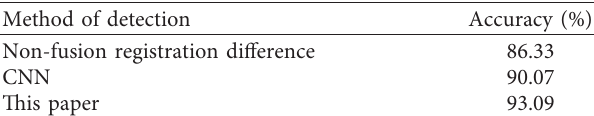
Table 5: Detection accuracy of different methods. Method of